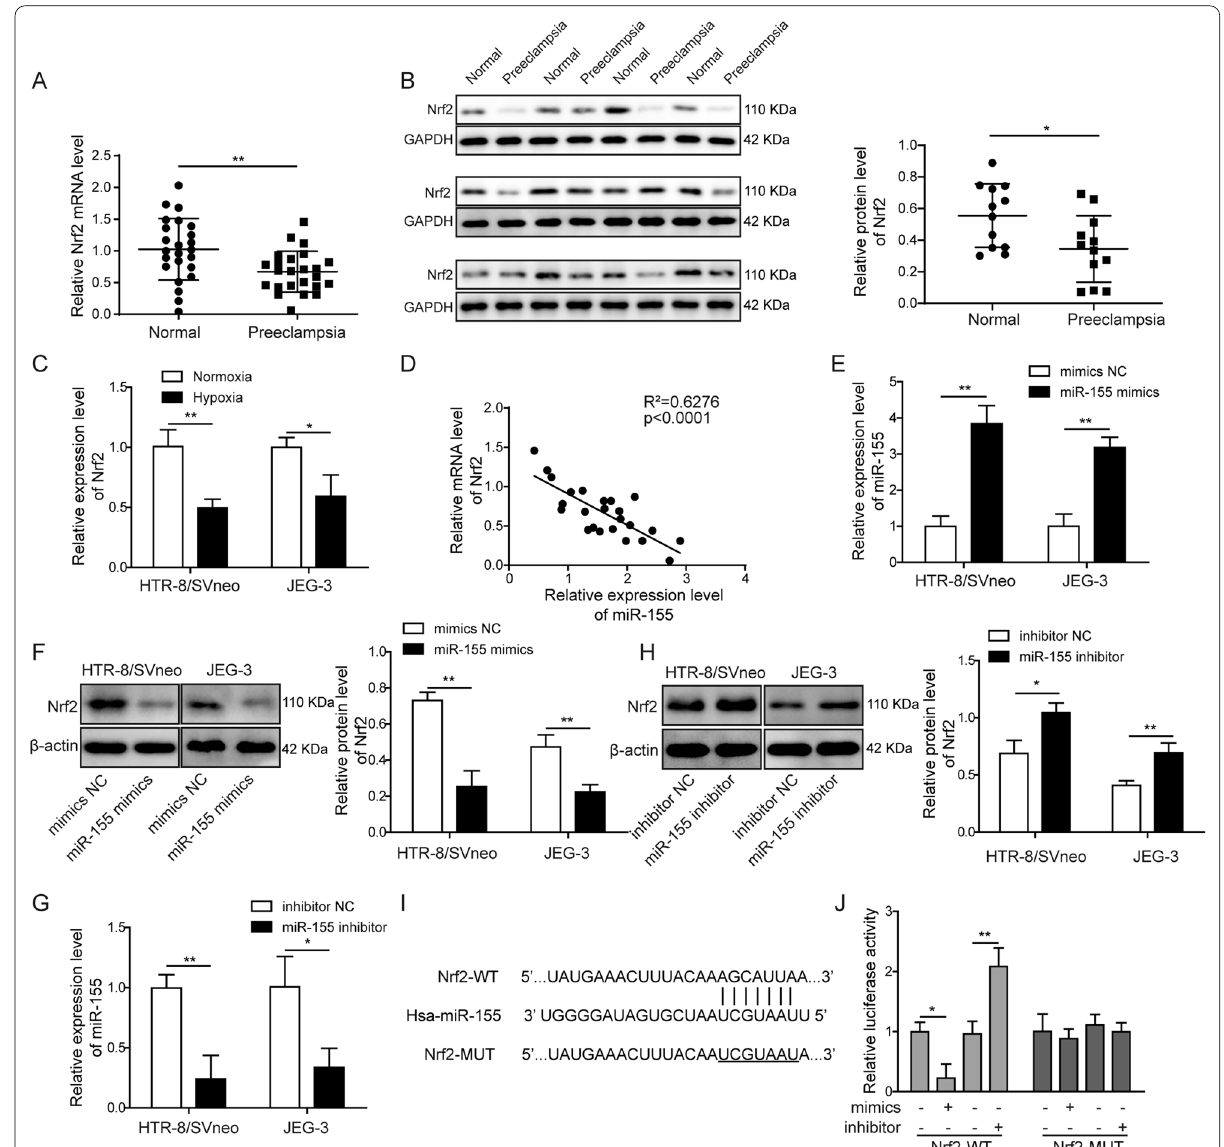
Fig. 6 MiR‑155 negatively regulates Nrf2 expression in trophoblasts. A qPCR measurement of Nrf2 mRNA levels in placenta tissues from preeclampsia patients (n 24) and normal pregnant women (n 24). B Western blot analysis of Nrf2 protein expression in placenta tissues from = = preeclampsia patients and normal pregnant women (n 12, randomly selected from 24 placenta tissues from preeclampsia patients and 24 = placenta tissues from normal pregnant women). C qPCR measurement of Nrf2 mRNA levels in HTR‑8/SVneo and JEG‑3 cells cultured under a normal or hypoxic condition. D A correlation analysis between miR‑155 and Nrf2 mRNA levels in placenta tissues from preeclampsia patients (n 24). E = qPCR measurement of miR‑155 levels in HTR‑8/SVneo and JEG‑3 cells transfected with miR‑155 mimics or mimics NC. F Western blot analysis of Nrf2 protein expression in HTR‑8/SVneo and JEG‑3 cells transfected with miR‑155 mimics or mimics NC. G qPCR measurement of miR‑155 levels in HTR‑8/SVneo and JEG‑3 cells transfected with miR‑155 inhibitor or inhibitor NC. H Western blot analysis of Nrf2 protein expression in HTR‑8/ SVneo and JEG‑3 cells transfected with miR‑155 inhibitor or inhibitor NC. I Bioinformatics analysis of the binding sites between miR‑155 and Nrf2. J Measurement of luciferase activities of wild type (WT) or mutated (MUT) Nrf2 using dual luciferase assay with enhanced or inhibited miR‑155 expression. All the experiments were repeated at least three times. * P < 0.05 and ** P <